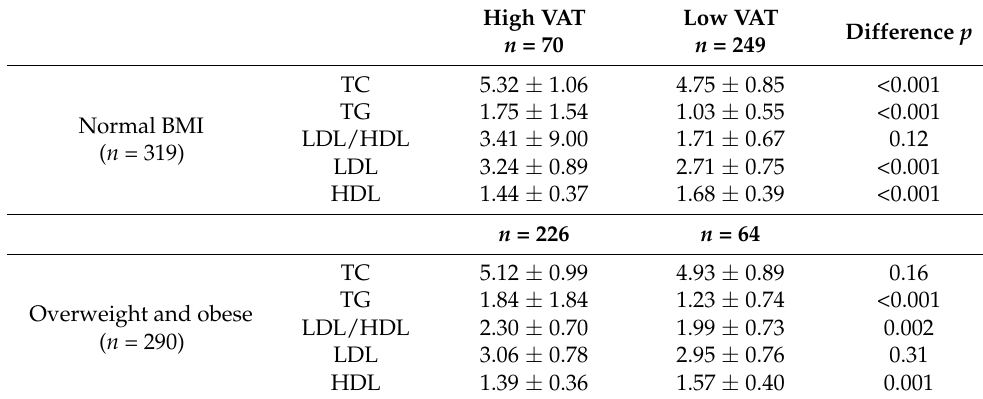
Table 6. Lipid profiles of Chinese women ( n = 609) according to BMI and visceral fat.